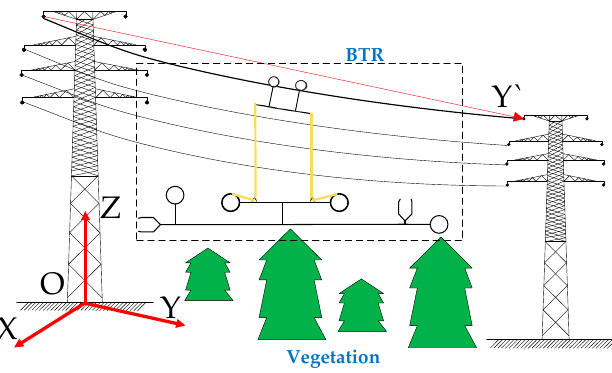
Figure 6. Working principle of the BTR.